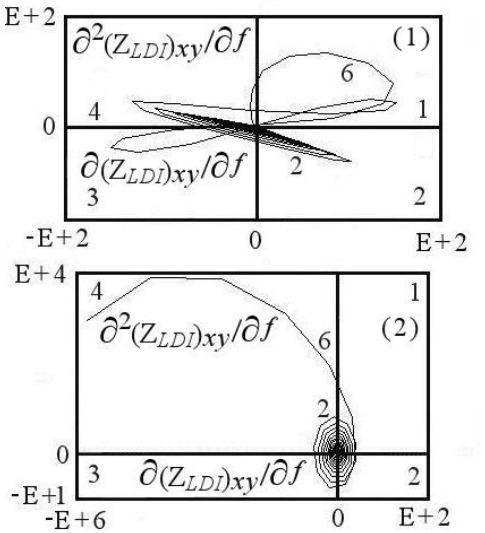
Figure 20. Phase-space for trajectory at low frequency and in different orientation ( 1 , 2 ) for potential between peak A and shoulder